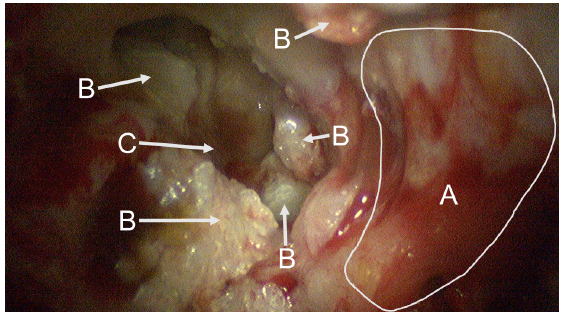
Figure 4. This endoscopic image shows the situs of the first patient captured at the beginning of the spectral data acquisition. In front, a large area of bone structure (A) is visible. Fragments of cholesteatoma (B) are present at different parts of the image. The round window niche (C) is visible in the